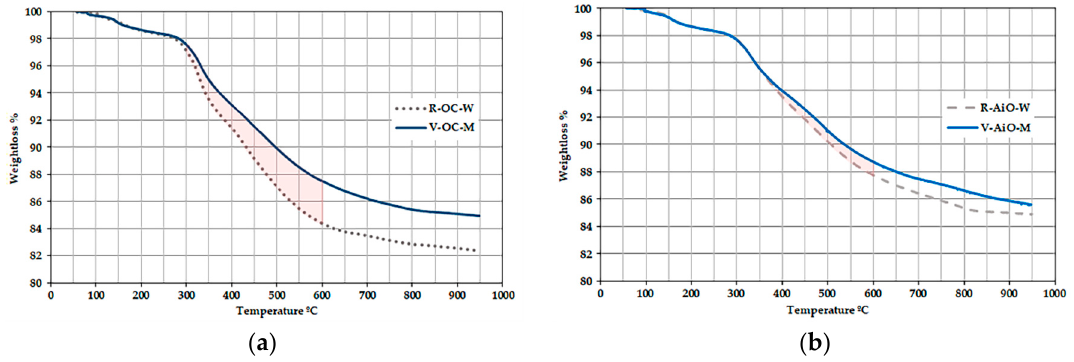
Figure 8. ( a ) Thermal Gravimetric Analysis (TGA) of OC; ( b ) TGA of AiO.